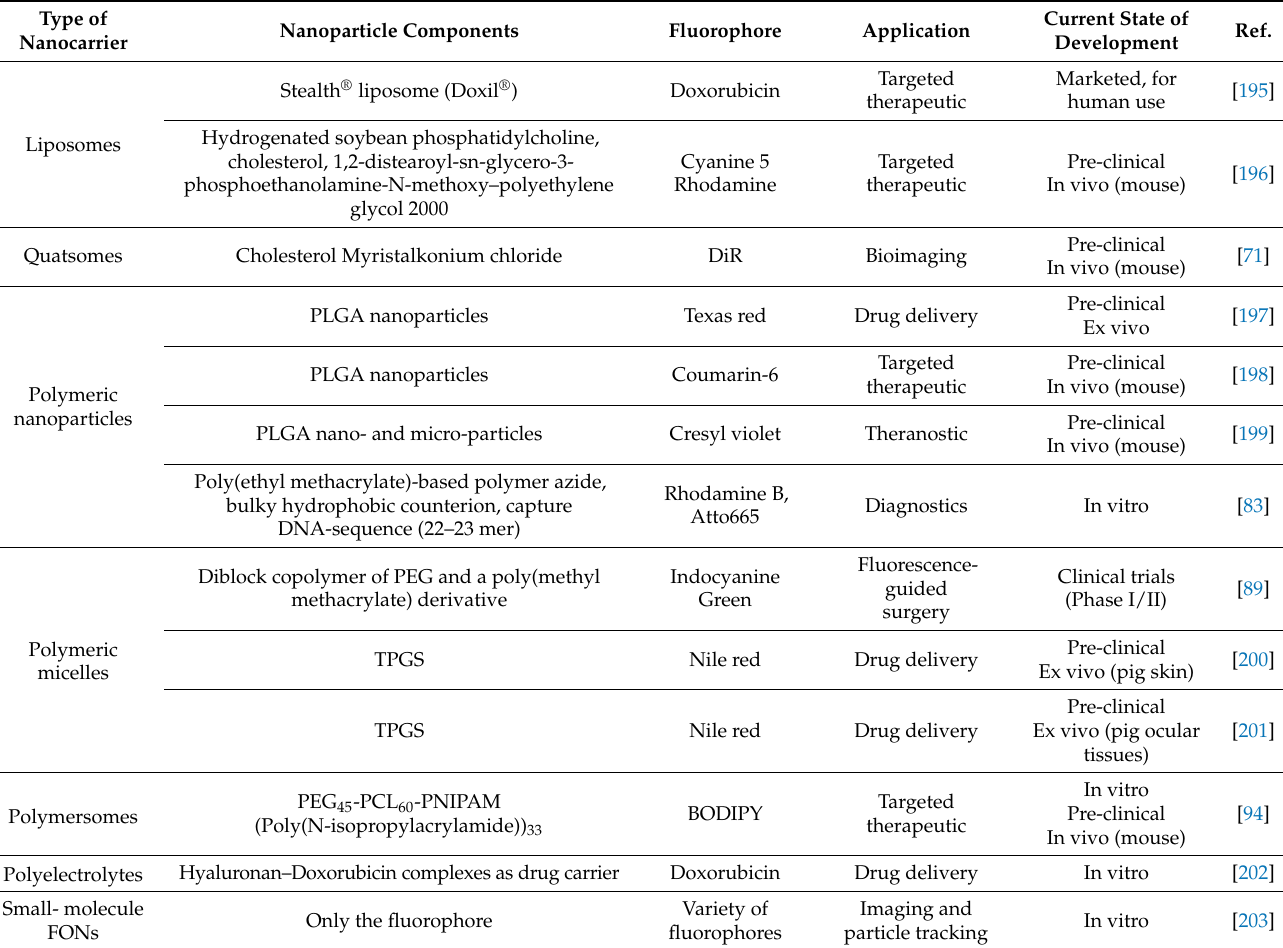
Table 4. Examples of organic nanoparticles and their application areas and current state of